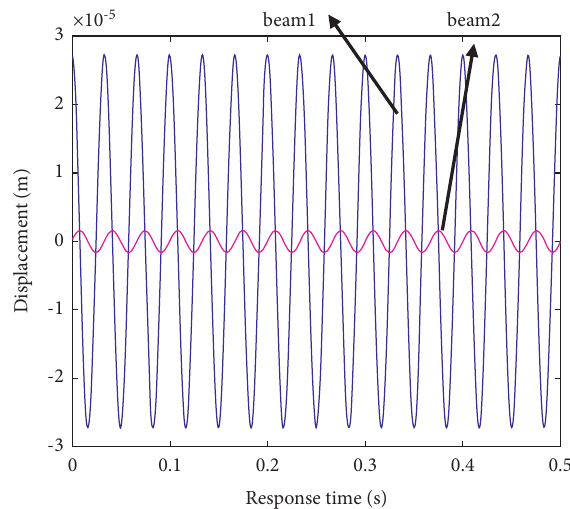
Figure 17: Time-domain response of the composite beam